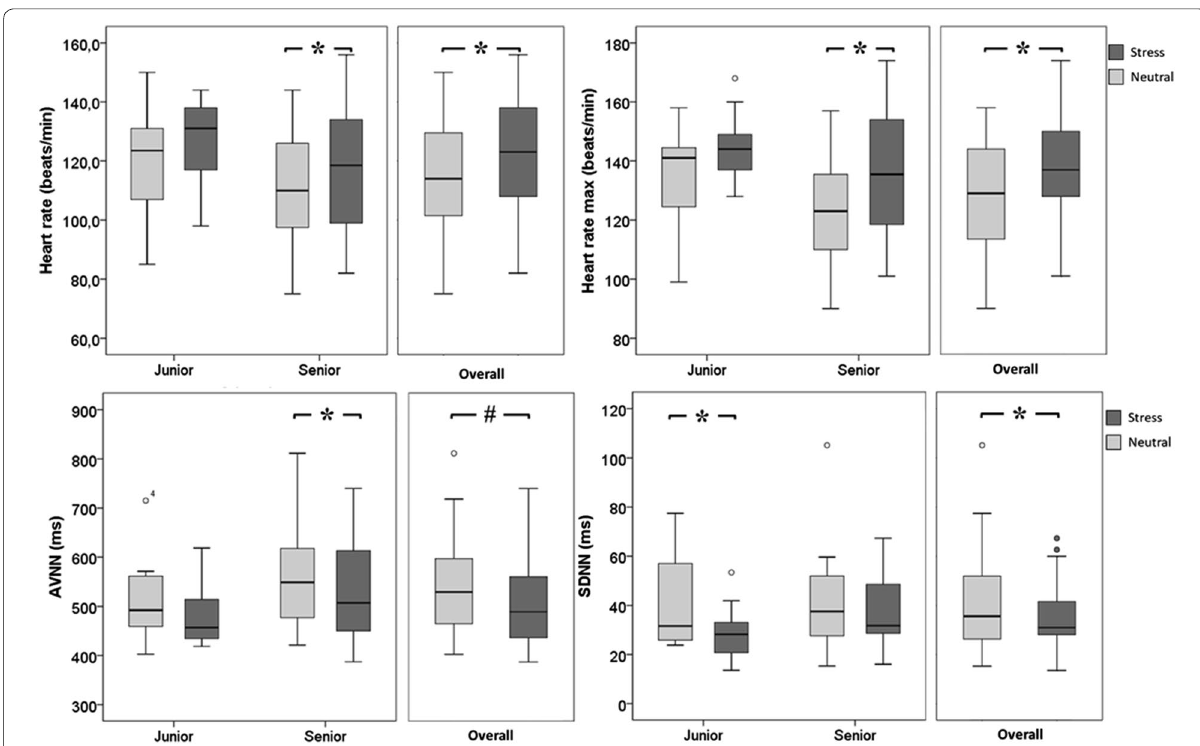
Fig. 1 Heart rate and heart rate variability measurement. AVNN is the average of RR interval, and SDNN is the standard deviation of RR. There was a difference in heart rate, max heart rate and AVNN for overall participants and for seniors, between stress and neutral scenarios. For juniors, there was a difference only for SDNN. * p < 0.01 # p < 0.0001. HRV is primarily dependent on the parasympathetic autonomic nervous system. Overall, there was a lower HRV between the 2 scenarios with the acceleration of HR, a SDNN and AVNN lower values. Statistical analysis shows significant results in different HRV parameter but not always at the same